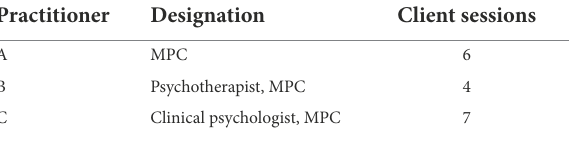
TABLE 2 Summary of practitioner characteristics and case